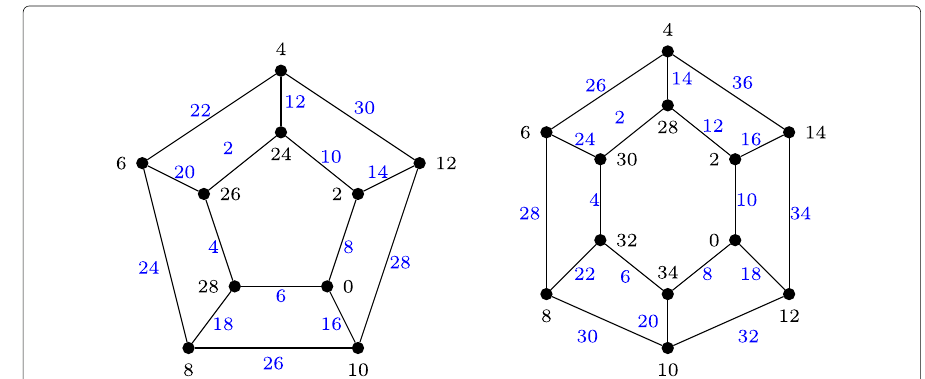
(cid:2) (cid:2) 5 and 6